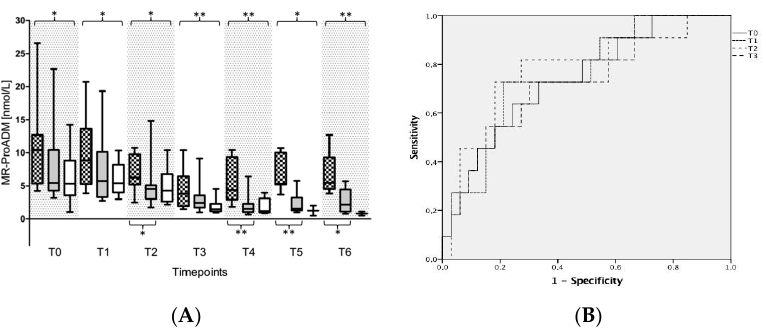
Figure 5. Plasma concentrations of mid-regional proadrenomedullin (MR-proADM) in patients with septic shock. Legend: ( A ) Plasma concentrations of MR-proADM were measured in patients suffering from septic shock with a fungal infection (grey squared box), a fungal colonization (grey plane box) or without any fungal findings (white box). Plasma samples were collected at the onset of septic shock (T0), and 1 day (T1), 2 days (T2), 7 days (T3), 14 days (T4), 21 days (T5), and 28 days (T6) afterwards. Data in box plots are given as median, 25th percentile, 75th percentile with the 10th as well as 90th percentile at the end of the whiskers. Concerning symbolism and higher orders of significance: * p < 0.05, ** p < 0.01; ( B ) Receiver operating characteristic (ROC) analysis with MR-proADM in all participating patients at sepsis onset (T0), and 1 day (T1), 2 days (T2) as well as 7 days (T3) afterwards with regard to the prediction of a fungal infection up to day 28. Patients suffering from a fungal infection represented the target group, whereas both, patients with a fungal colonization as well as patients without any fungal isolates, served as controls for this ROC-analysis.